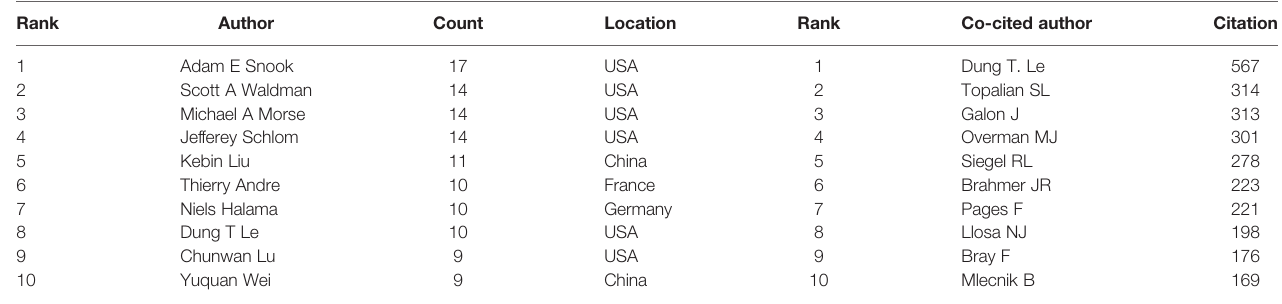
TABLE 5 | Top 10 most proli fi c and co-cited authors in the fi eld of colorectal cancer